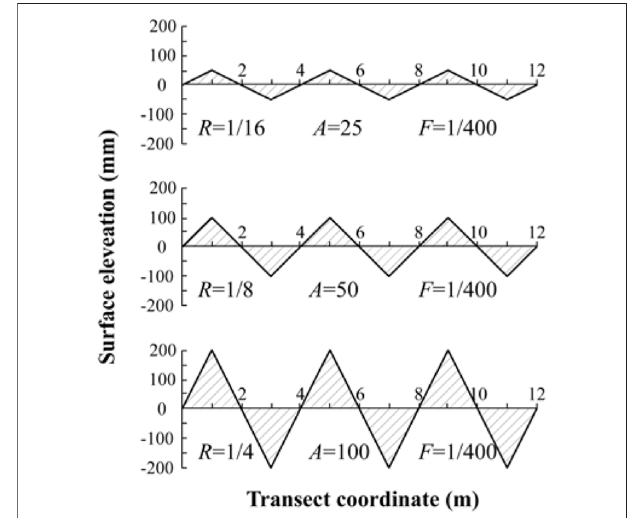
FIGURE 1 | Schematic representations of ground roughness (modi fi ed from Romkens and Wang